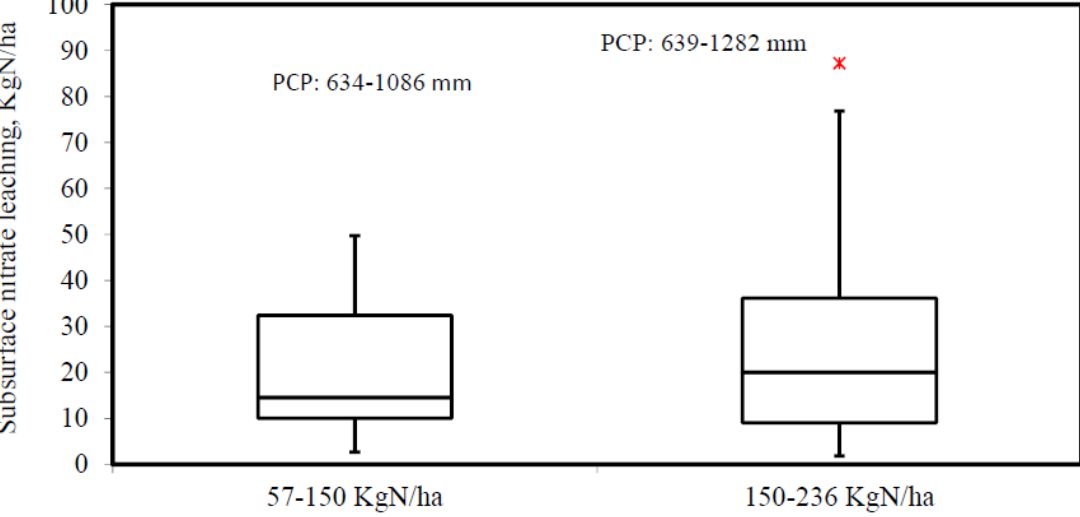
Figure 7. Subsurface nitrogen leaching from fine loamy soil in rotated corn (twelve journal articles were used for analysis).